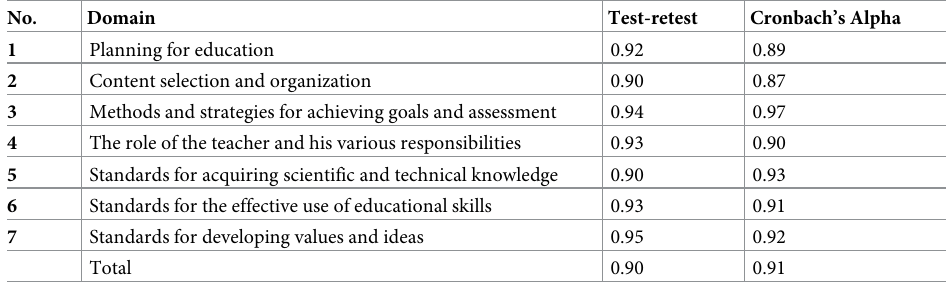
Table 2. Test-retest and Cronbach’s Alpha coefficients of the study